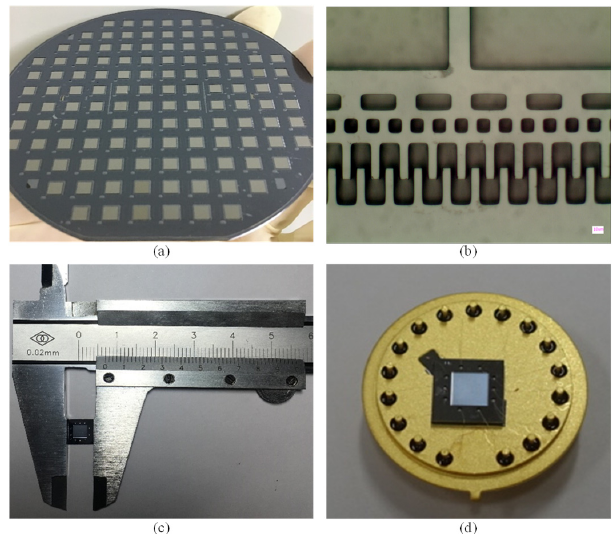
Figure 4. ( a ) Photograph of a patterned wafer after anodic bonding between the SOI wafer and the glass cover with gloves where getter materials was sputtered. ( b ) Microscopic image of detailed comb-drive electrodes in the fabricated resonator. ( c ) Photograph of a prototype sensor with a dimension of 7 mm × 7 mm. ( d ) Photograph of a fabricated sensor mounted on a covar 7 mm × 7 mm. ( d ) Photograph of a fabricated sensor mounted on a covar header.